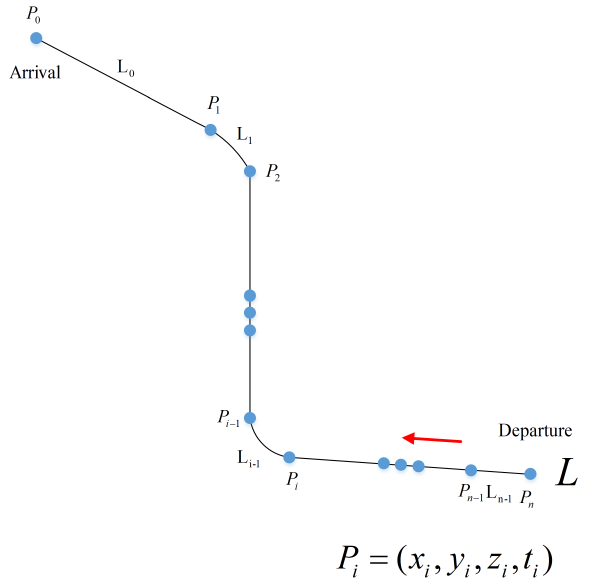
Figure 3. Line and arc flight